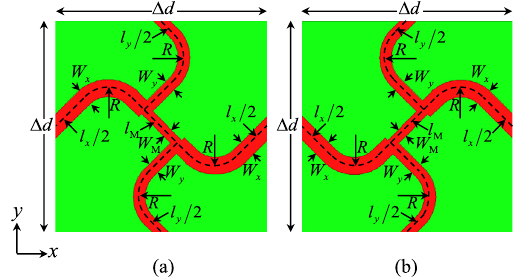
Fig. 16. Implemented unit cells of the distributed full-tensor anisotropic medium of Figure 3. (a) m xy > 0. (b) m xy < 0.